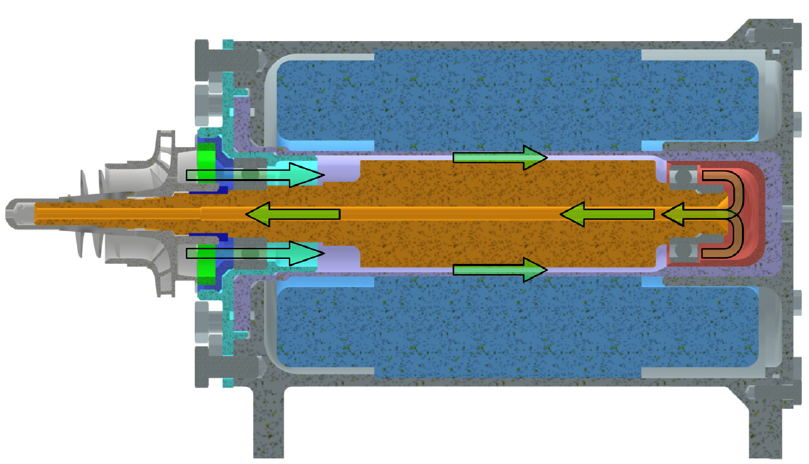
Figure 5. Electric pump structure.